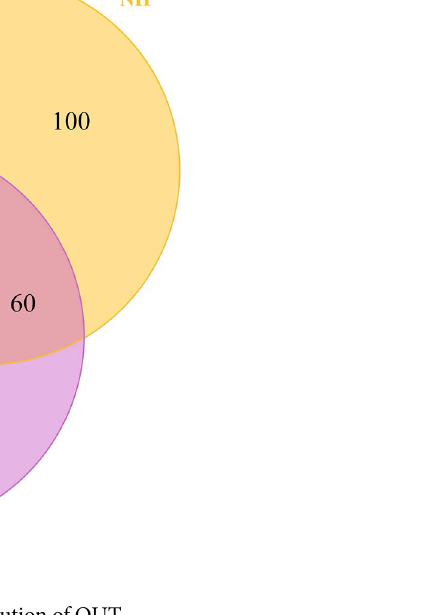
Figure 1. Venn diagram denoting the distribution of